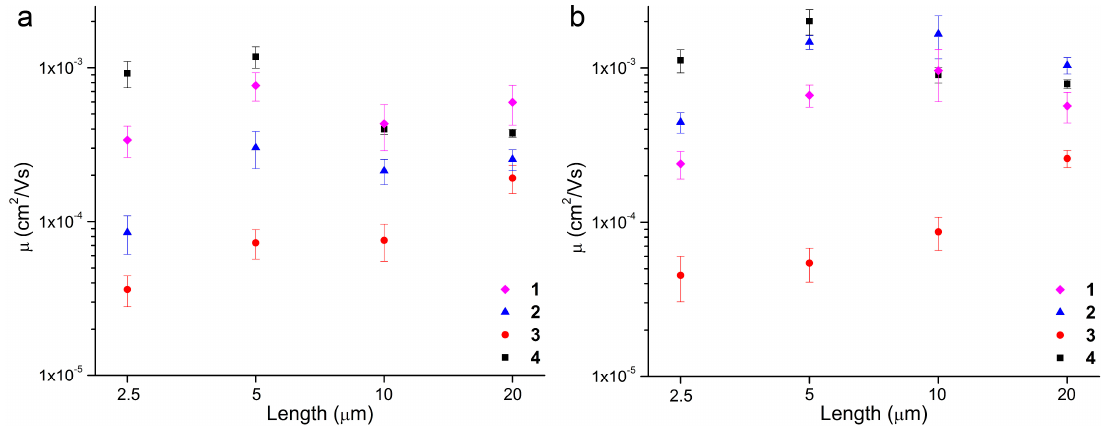
Figure 4. Comparison of mobility data for devices tested in ( a ) vacuum and ( b ) air.